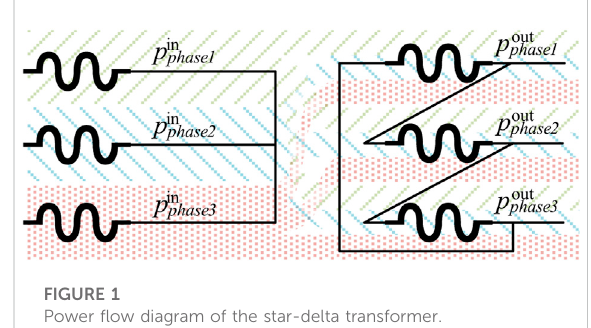
FIGURE 1 Power fl ow diagram of the star-delta transformer.